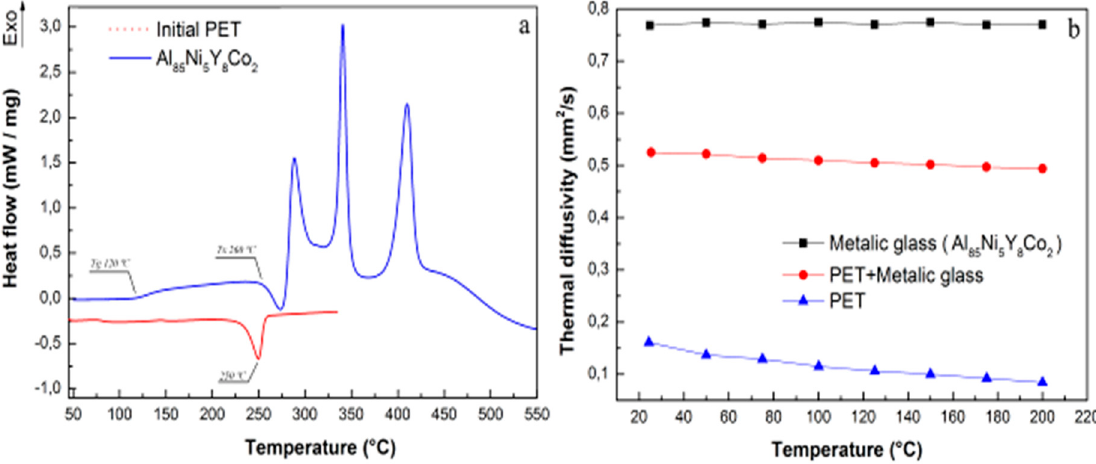
Figure 3. Differential scanning calorimetry (DSC) analysis of the Al 85 Y 8 Ni 5 Co 2 ribbon sample and polyethylene terephthalate powder sample ( a ), and thermal conductivity of pure PET samples, Al 85 Y 8 Ni 5 Co 2 metallic glass, and composite samples ( b ). Table 1. Phase composition of the obtained